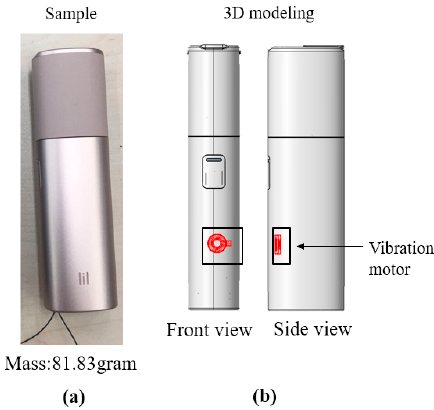
Figure 9. ( a ) Sample and ( b ) three-dimensional (3D) model of an E-cigarette.